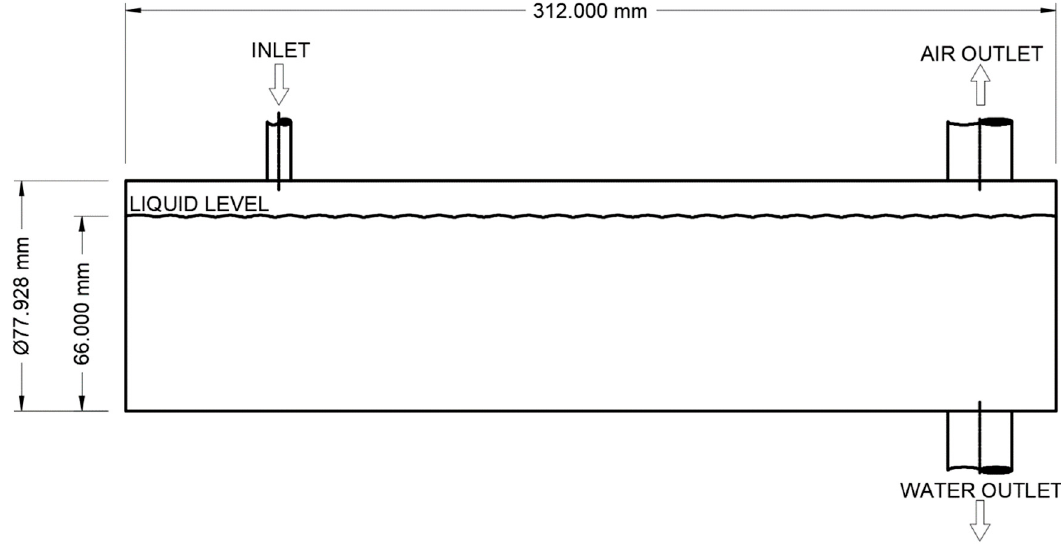
Figure 1. Sketch of the separator and its dimension used in the experiment.